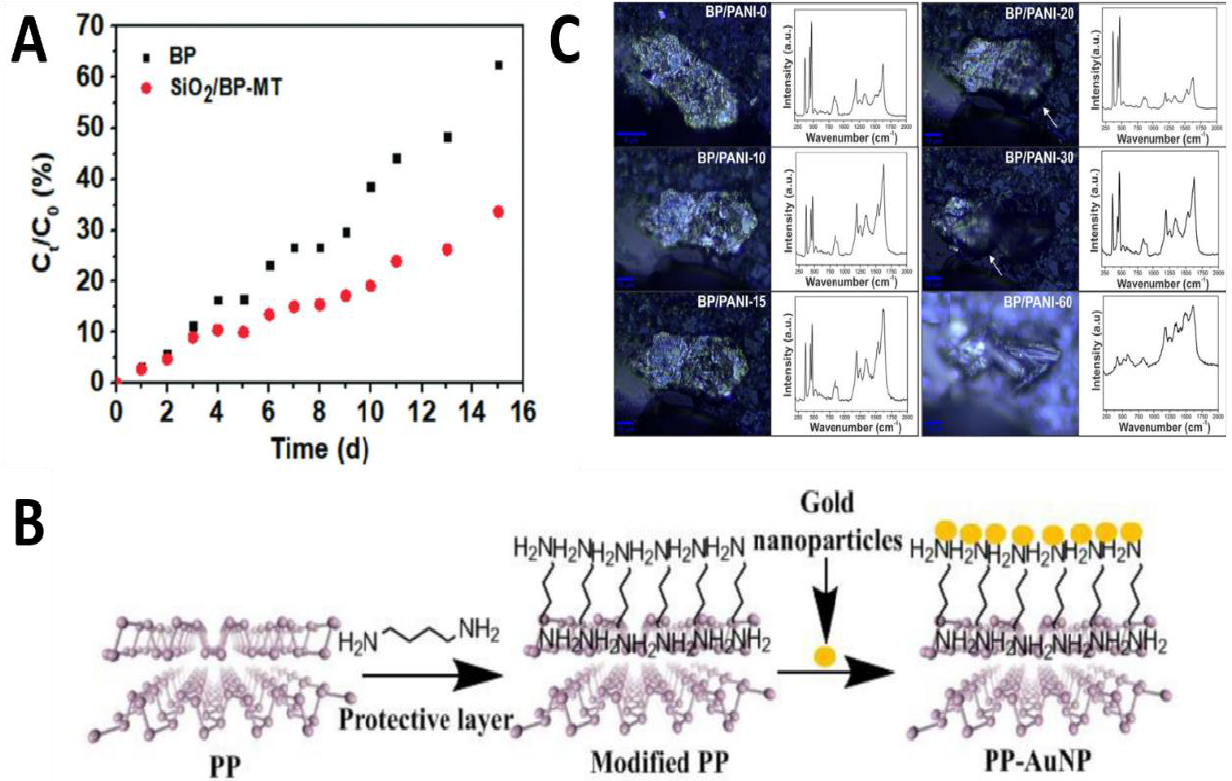
Figure 6. ( A ) The exposed BP and modified BP degraded over time. Reproduced with permission [87]. Copyright 2020, The Royal Society of Chemistry. ( B ) HMA is coated on BP and attached to the surface with gold for biosensors. Reproduced with permission [85]. Copyright 2018, Elsevier. ( C ) Optical images and Raman spectra ( λ = 532nm) of BP/PANI nanocomposite deposited over a glass substrate after 0, 10, 15, 20, 30, and 60 days of exposure to ambient conditions. Reproduced with permission [82]. Copyright 2017, Springer Nature Limited.